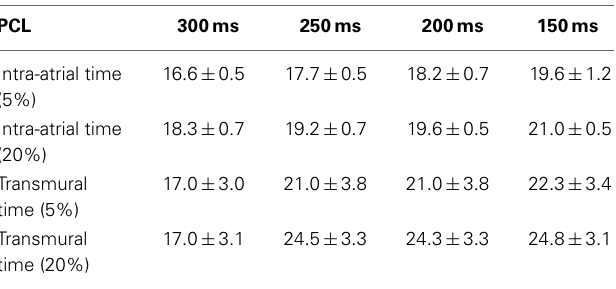
Table 1 | Comparison of the intra-atrial and transmural conduction time (ms) under normal (5% CO 2 ) and hypercapnic (20% CO 2 ) conditions in isolated Langendorff-perfused rabbit hearts ( n = 5) at four pacing cycle lengths (PCL).